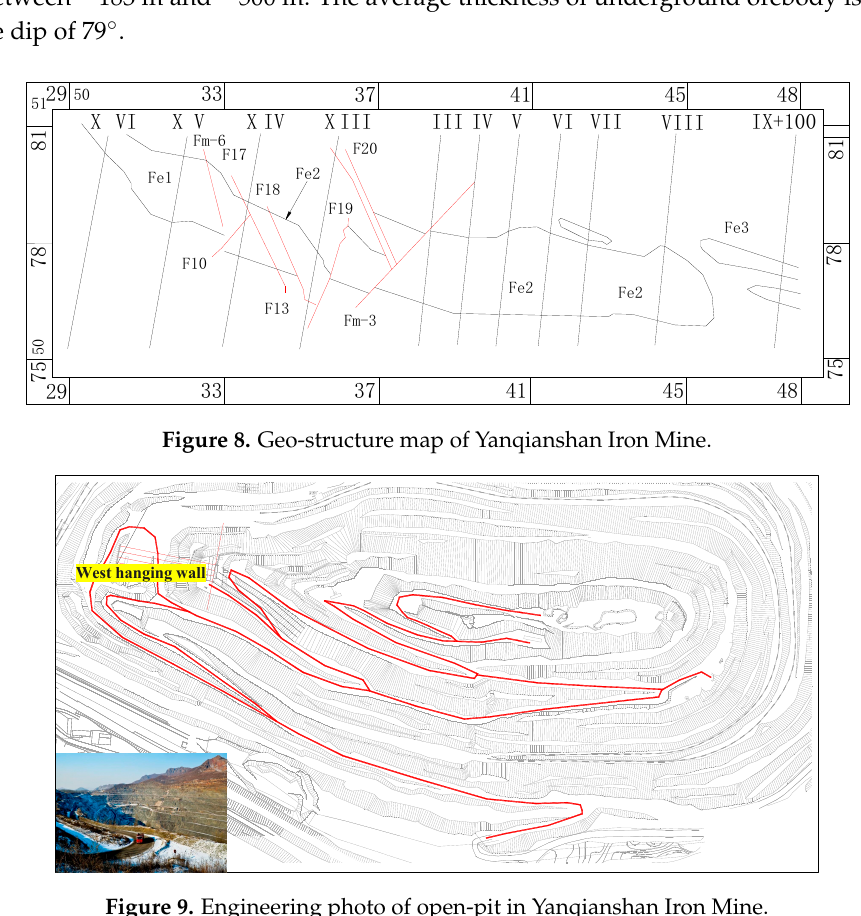
Figure 9. Engineering photo of open-pit in Yanqianshan Iron Mine.